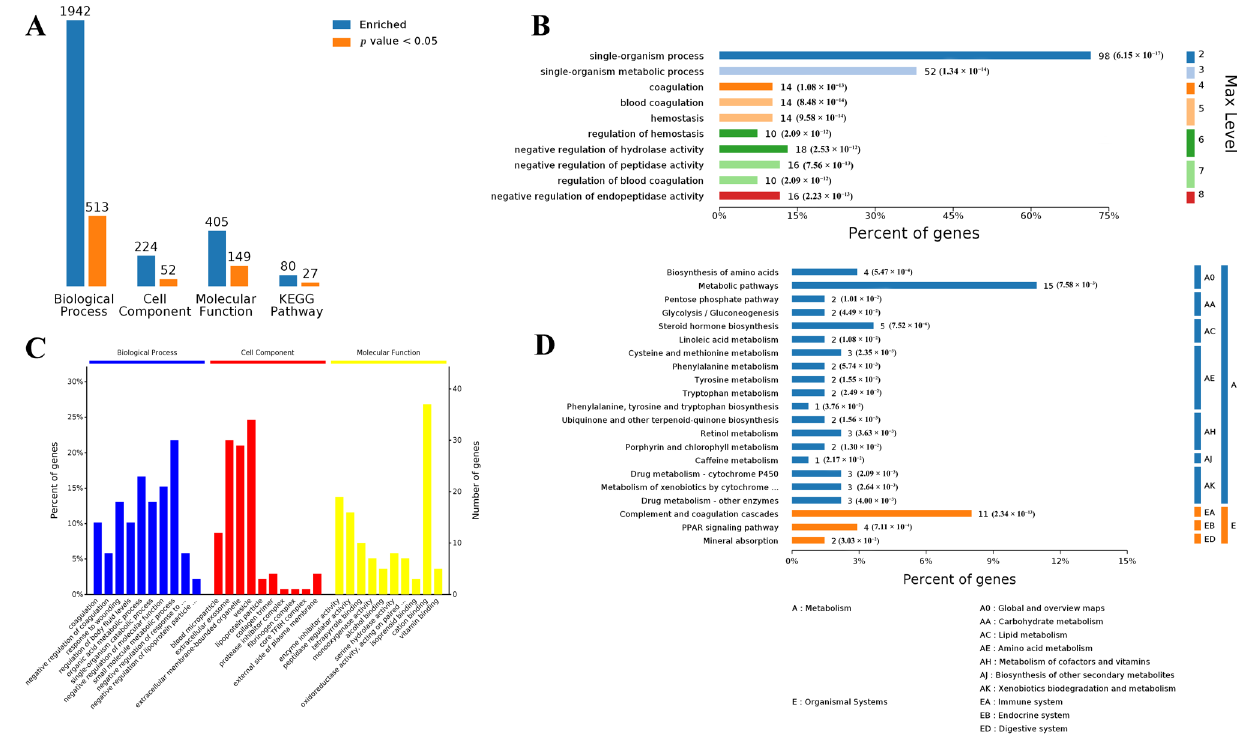
Figure 2. Bioinformatic analysis of DEGs in muscle tissue using four analysis categories: biological process (BP), cell component (CC), molecular function (MF), and Kyoto Encyclopedia of Genes and Genomes (KEGG) pathways. ( A ) Counts for each category represent the total associated terms in the database with the query protein list. Terms with p value < 0.05 are statistically significant. ( B ) BP hierarchy of DEGs, the number of involved genes, and corresponding p value in a specific biological process are shown on the right side of the column. ( C ) The ten most significantly enriched terms in level 4 of gene ontology hierarchy, information of percentage, and a number of involved genes in a term are shown in the left and right y-axes. ( D ) KEGG hierarchy of DEGs, the number of involved genes, and corresponding p value in a specific biological process are shown on the right side of the column.